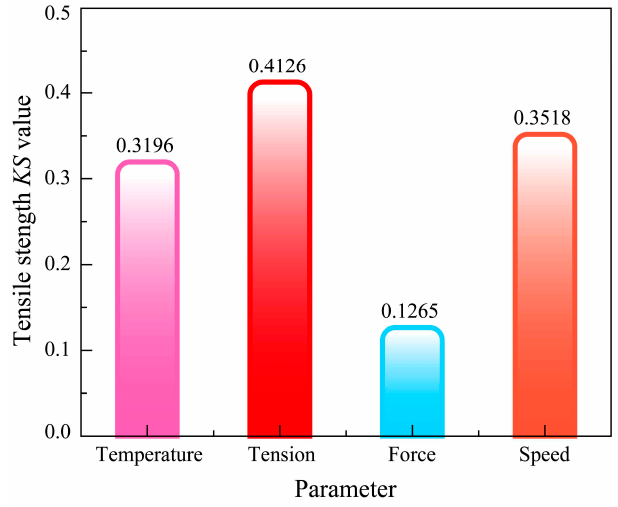
Figure 8. Cartogram of KS values for the tensile strength model.